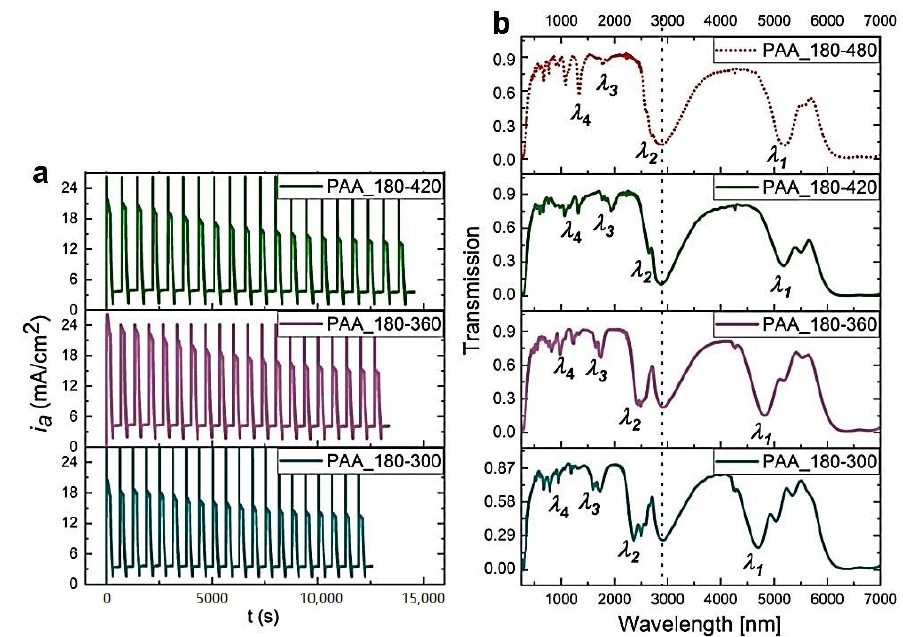
Figure 9. The i a ( t ) curves recorded during pulse anodization at 30 °C, under U L of different t L [s] (PAA_t H -t L , other parameters: U H = 50 V, U L = 20 V, U H - > U L drop rate = 0.234 V/s, 20 cycles) ( a ) and the corresponding transmission spectra (the transmission spectra for the PAA_180-480 is shown for comparison) ( b ).